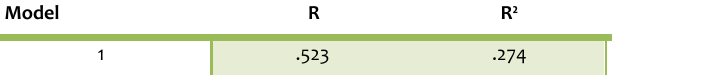
Tabela 6. Prikaz predikcije i varijanse za doprinos stručnog usavršavanja odnosu prema društvenim sadržajima Model